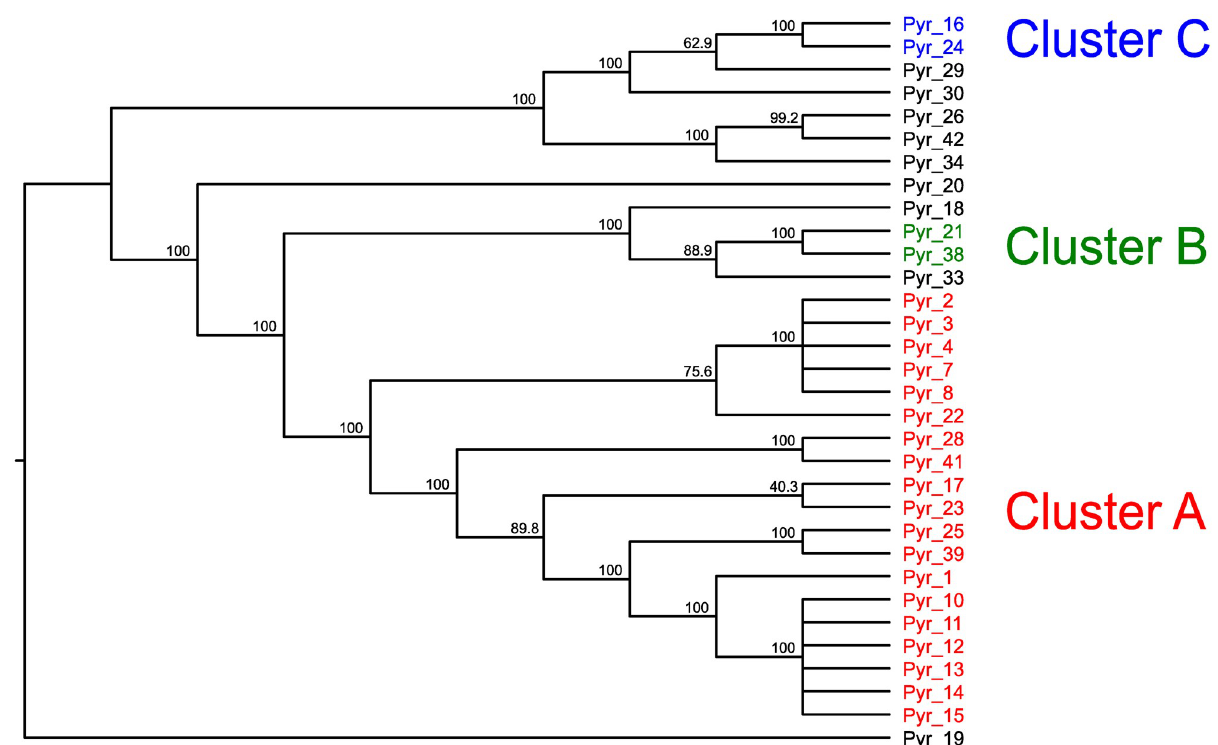
Fig 7. Phylogenetic tree constructed using the SVDquartets with PAUP using nuclear DNA data of 31 Pyropia yezoensis samples and 1 P . tenera . The numbers at the nodes indicate bootstrap values (% over 1,000 replicates). The data of Pyr_19 ( P . tenera ) was used as a root. Colors of the sample names were used to show 3 clusters, cluster A, B, and